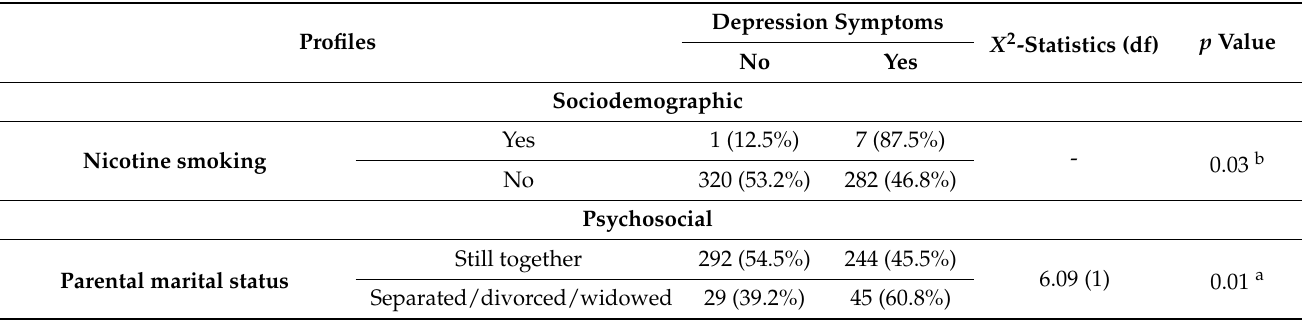
Table 2. Significant associations of sociodemographic, psychosocial and academic profiles of phar- macy students with depression symptoms (n =